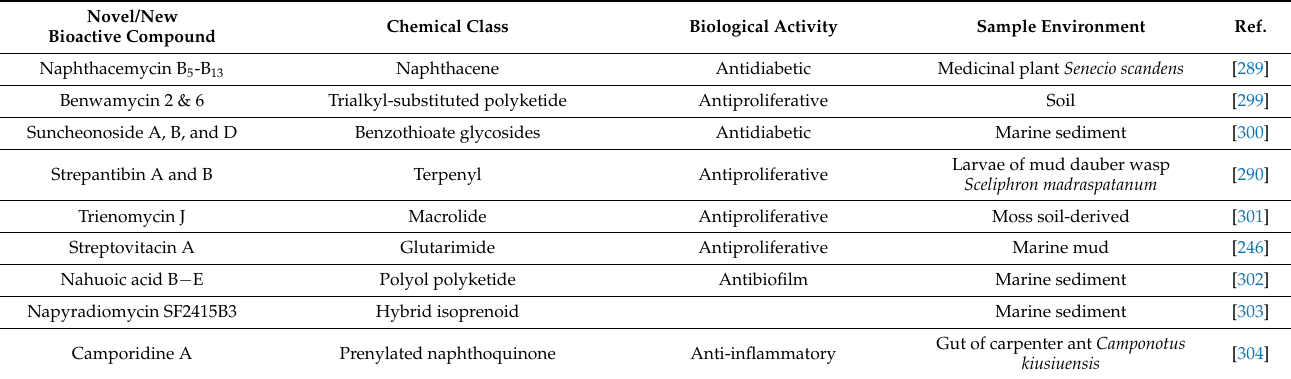
Table 13. Other biological activity from novel/new compounds isolated from Streptomyces spp. between 2015 and